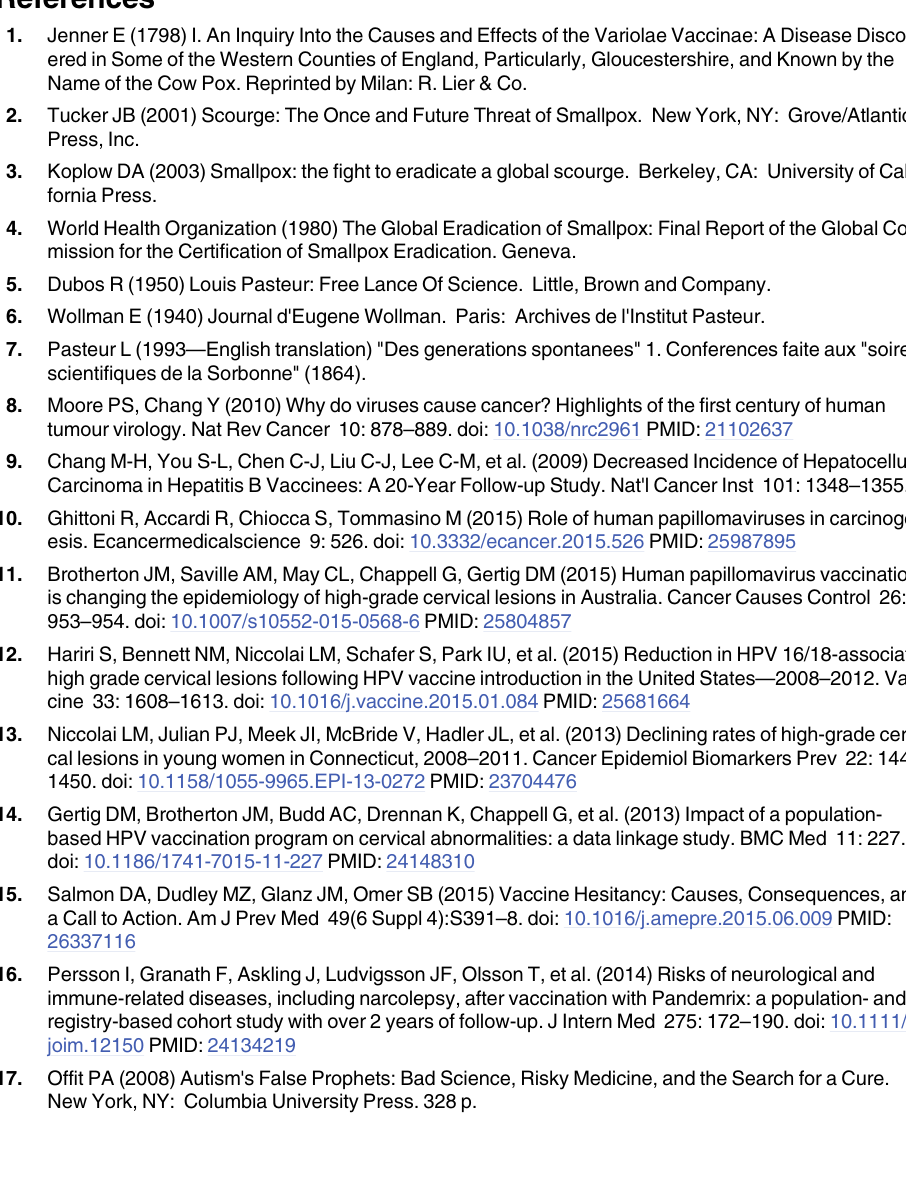
PLOS Pathogens | DOI:10.1371/journal.ppat.1005320 January 14,